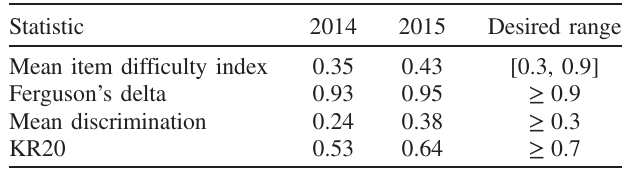
TABLE II. ACI post-test statistics for the 2014 and 2015 classes. Sample sizes were N ¼ 76 and N ¼ 87 ,